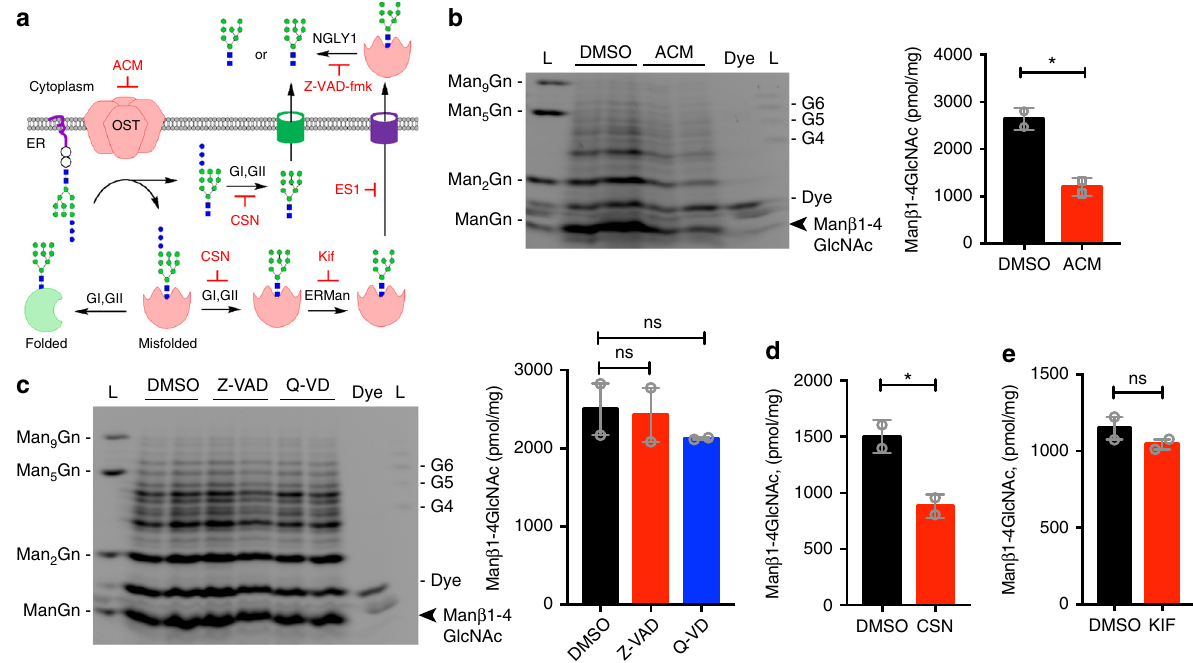
Fig. 2 The Man β 1-4GlcNAc disaccharide originates from glycans produced by the OST. a A schematic diagram of two major biogenesis pathways of fOS in mammalian cells, OST hydrolysis of LLO and NGLY1 cleavage of N-glycans, and pharmacological inhibitors (red) that blocks either pathway. b FACE analysis of fOS pool isolated form Trex1 − / − MEFs treated with 1 μ M aclacinomycin (ACM) for 24 h. Quanti fi cation of the Man β 1-4GlcNAc disaccharide band is shown on the right (same below). c FACE analysis of fOS pool isolated form Trex1 − / − MEFs treated with 30 μ M Z-VAD or 50 μ M Q-VD for 24 h. d, e Quanti fi cation of the Man β 1-4GlcNAc disaccharide in Trex1 − / − MEFs treated with 100 μ M of castanospermine (CSN, D) or 100 μ M of kifunensine (KIF, E) for 24 h. Representative FACE gels are in Supplementary Fig. 4. Data are representative of at least three independent experiments. Error bars indicate SEM. Unpaired t